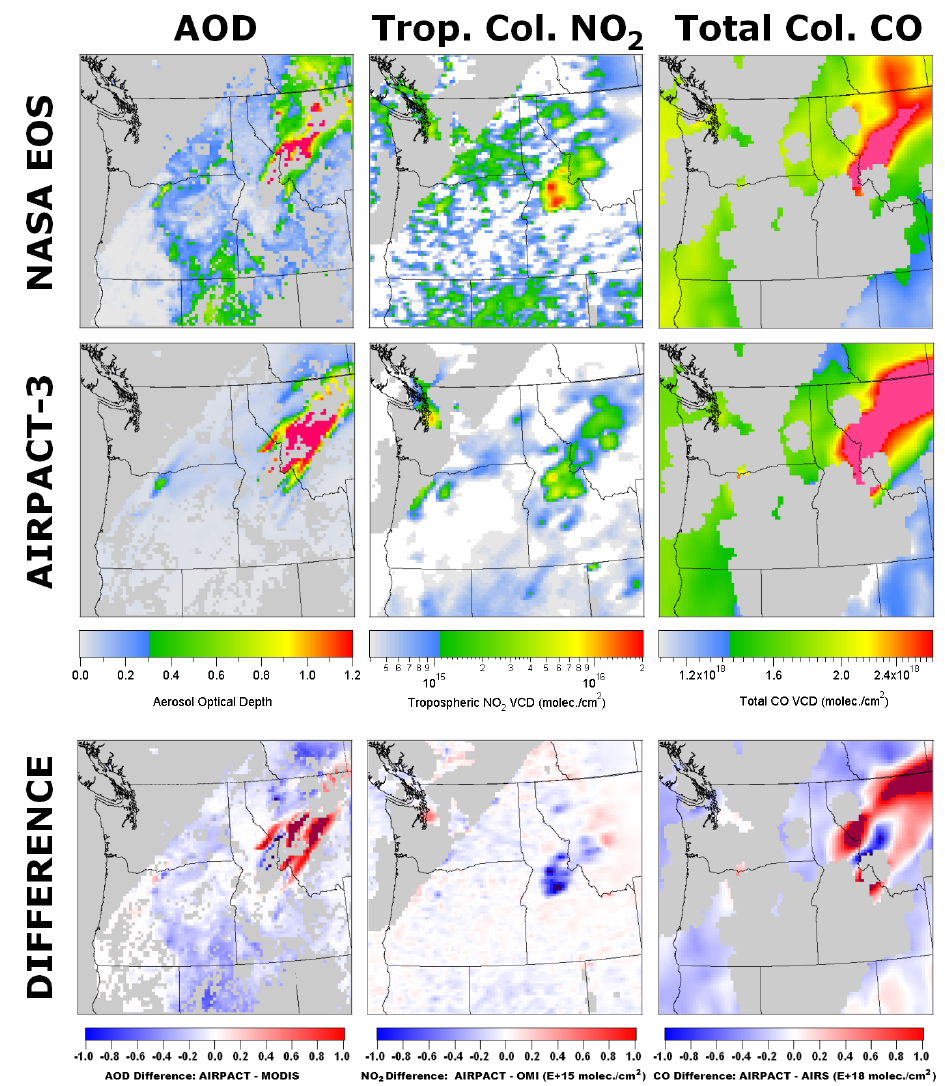
Figure 4. AOD (left column), tropospheric NO 2 columns (middle column), and total carbon monoxide columns (right column) for 12 August 2007 ( ∼ 2 p.m. LST) with NASA EOS retrieval (top row), AIRPACT-3 with SMOKE plume rise (middle row), and differences (bottom row). Gray color indicates no or low-quality data from the satellite retrieval and exclusion from analysis. Values greater than the color scale maximum are shown as pink in the AIRPACT-3 and NASA EOS maps. Values outside the range of the difference color scales are shown as saturated